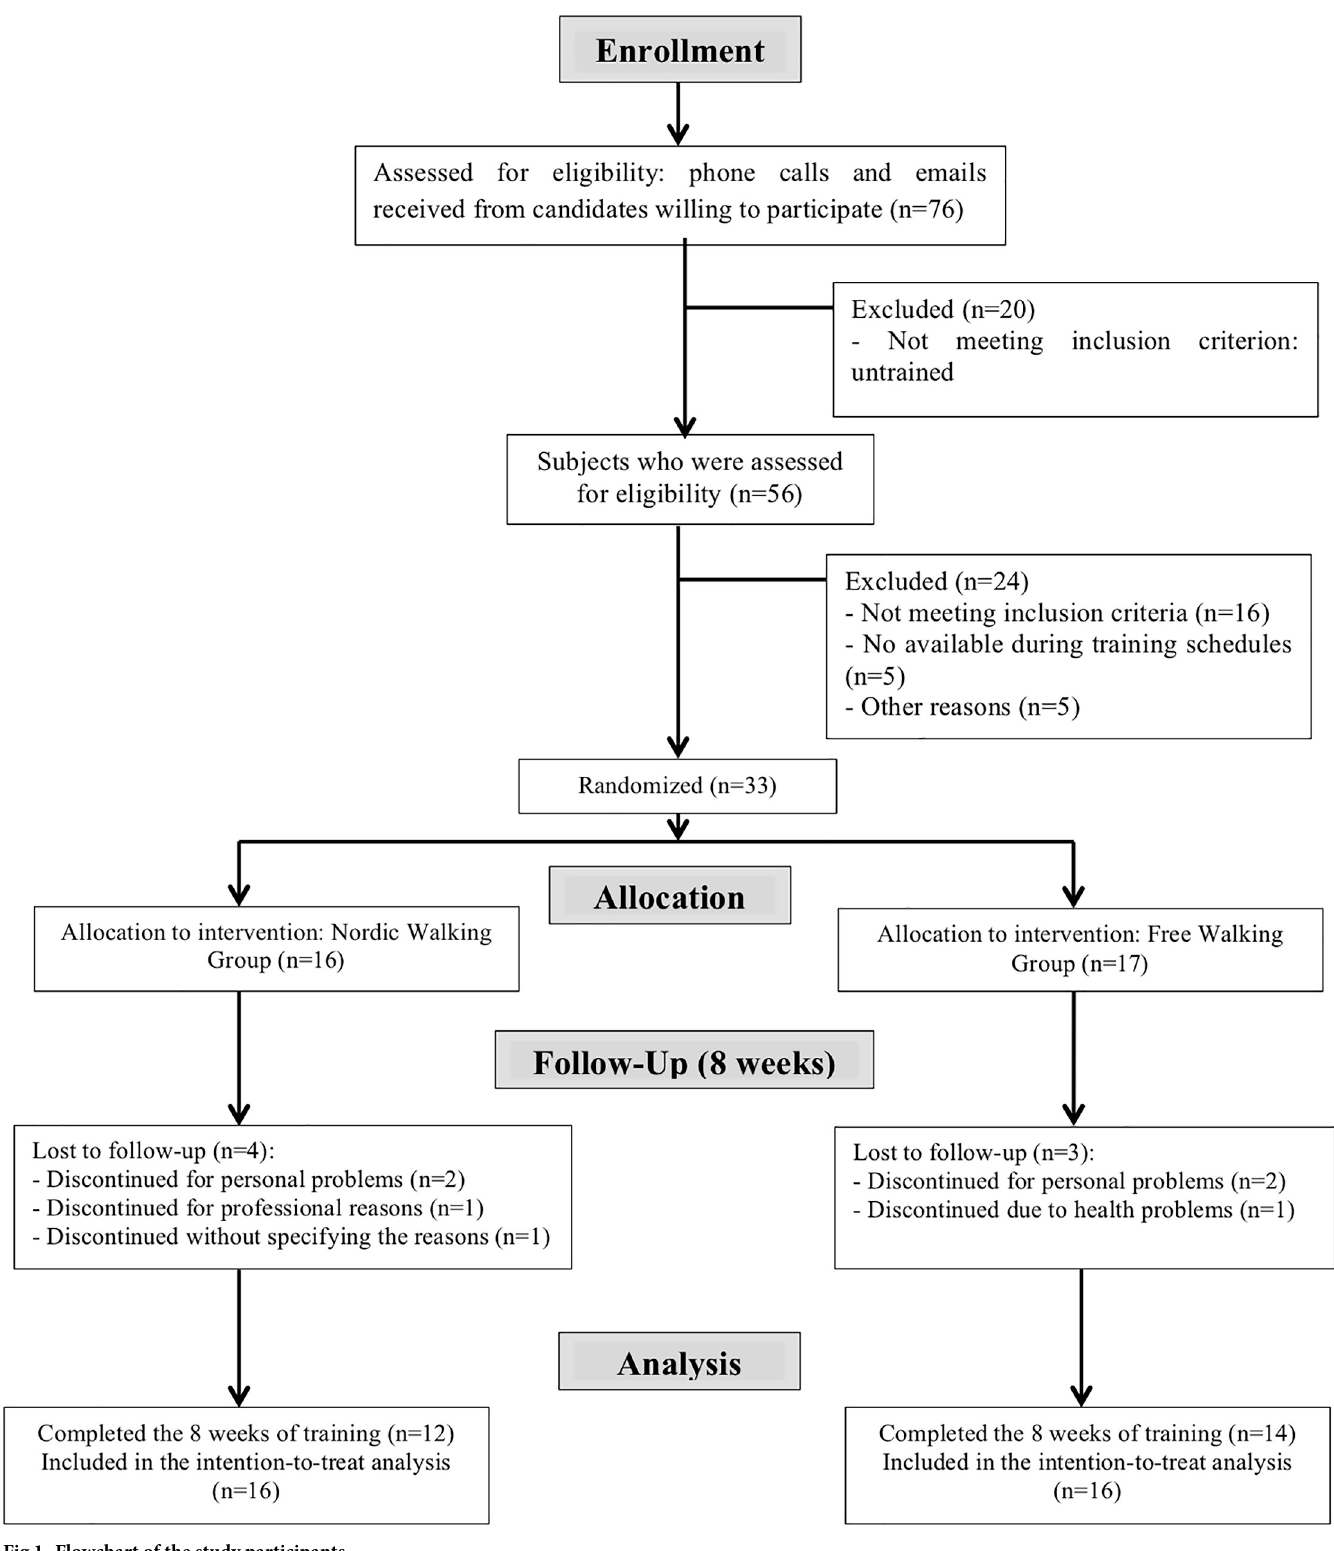
Fig 1. Flowchart of the study participants.